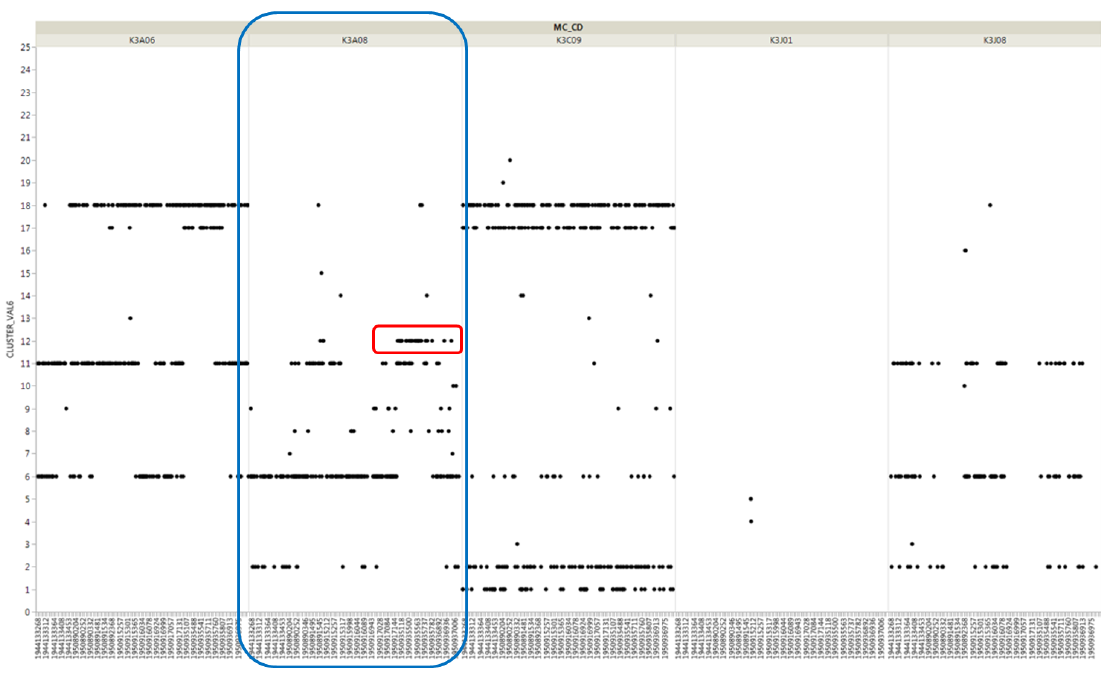
Figure 8. Cluster type of vulcanizer K3A08 by time stream.